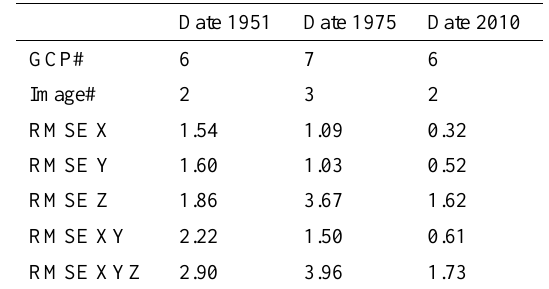
Table 3. RMSE of residuals on the GCPs [units: m]